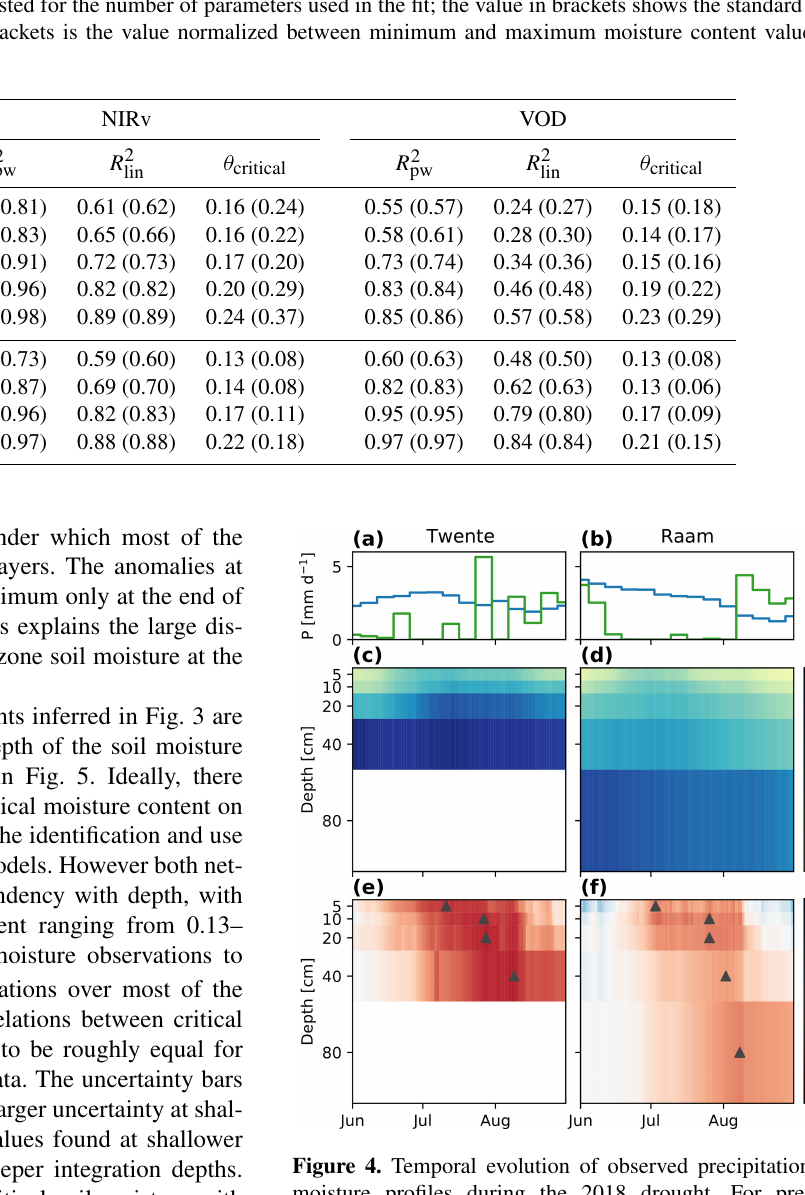
values are shown for both the adjusted